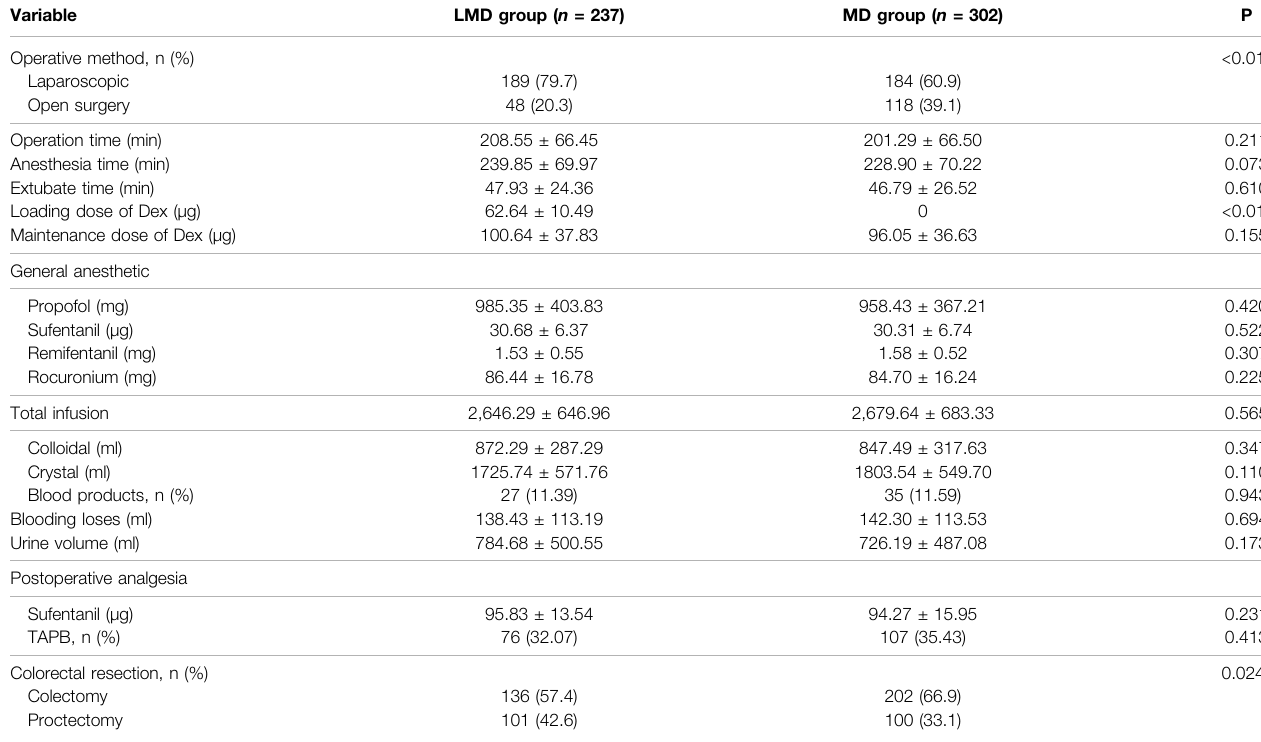
TABLE 2 | Indicators related to surgical and anesthesia.